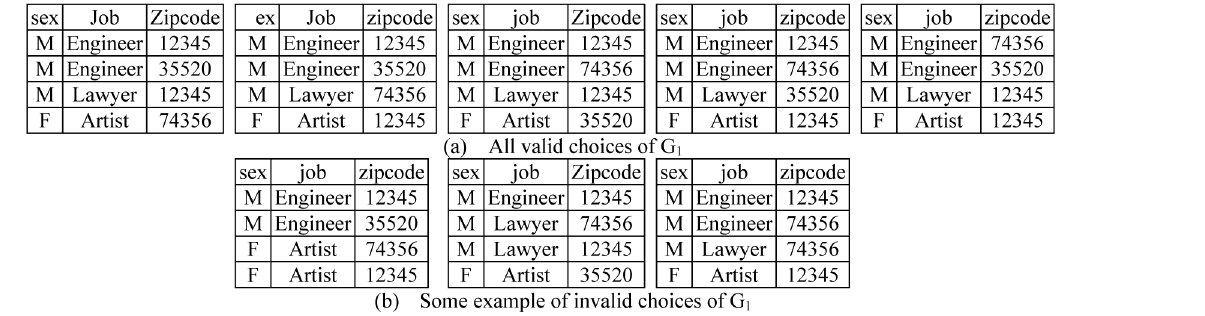
Fig 3. All valid choices and some invalid choices for reconstructing group G 1 from Fig